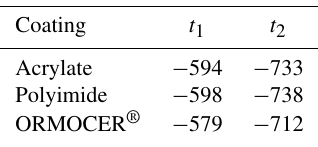
Table 7. Average strain values of the reference measurement (in µ ε